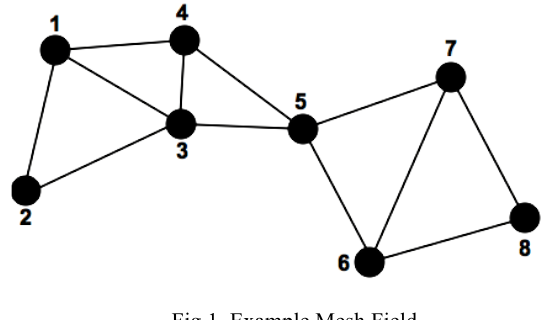
Fig.1. Example Mesh